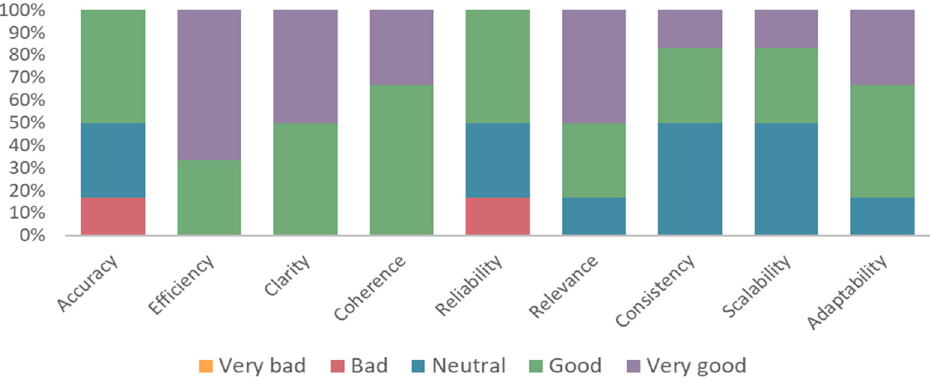
Figure 5. Results from the survey regarding the evaluation of the ChatGPT output.